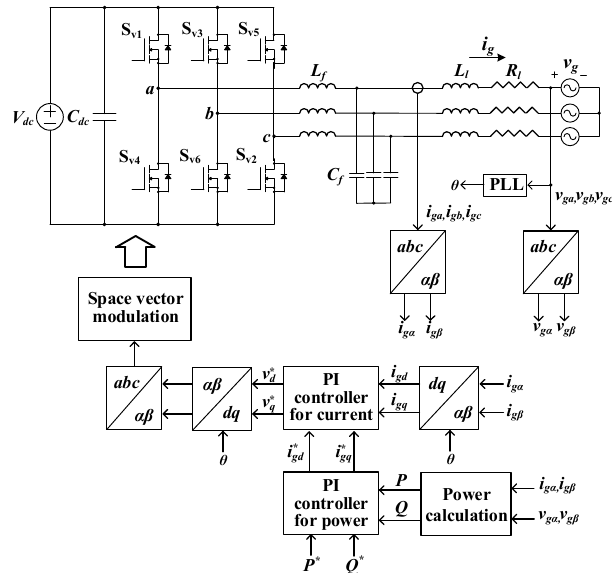
Figure 22. Grid-connected voltage source inverter.